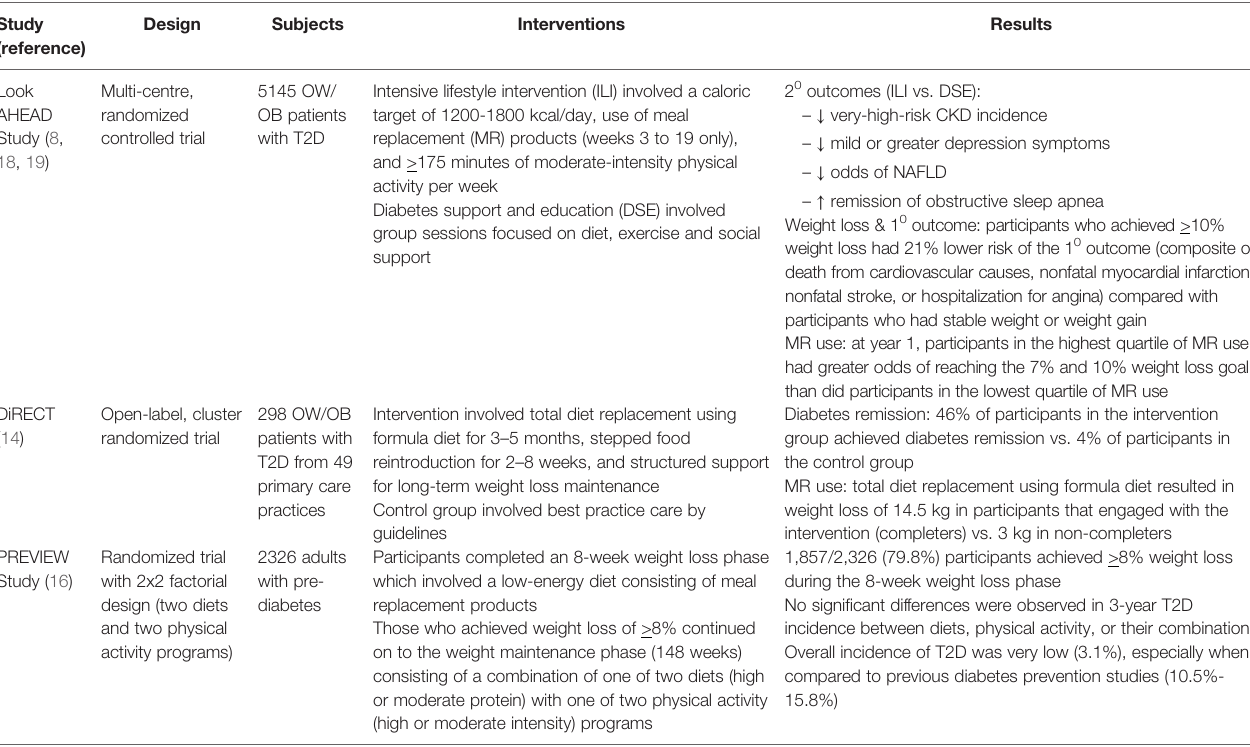
TABLE 1 | Summary of large-scale randomized controlled trials incorporating meal replacements as part of a comprehensive lifestyle intervention in diabetes